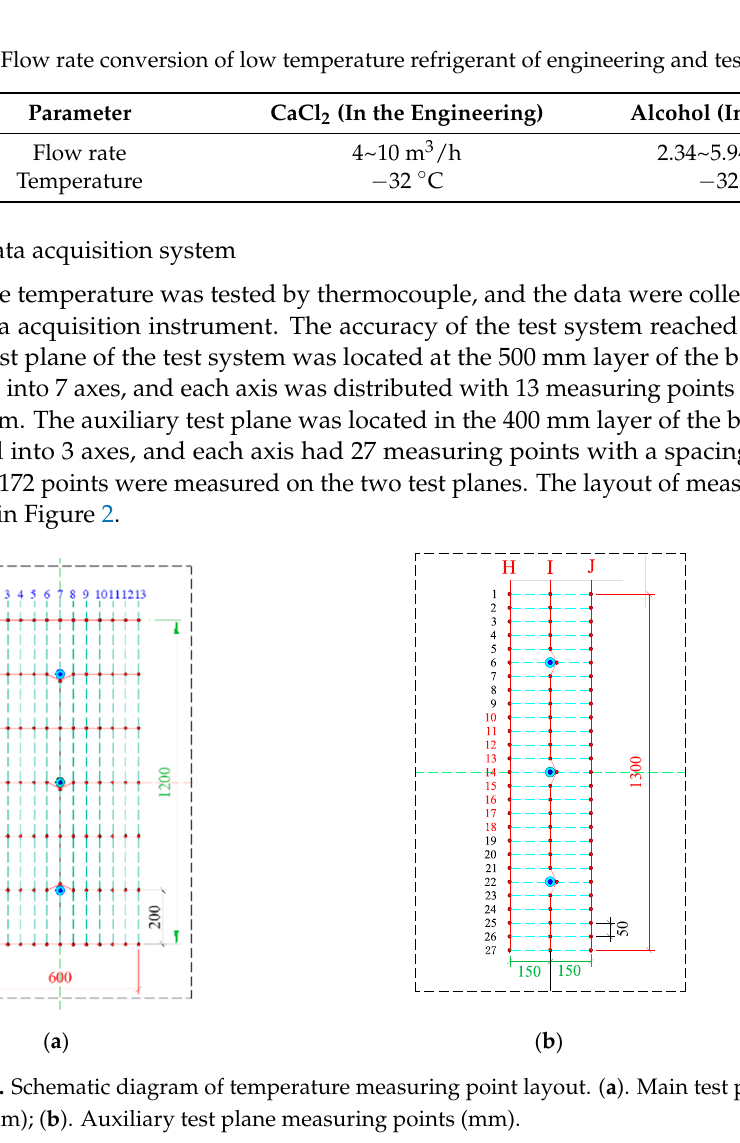
Table 3. Comparison of physical parameters between CaCl 2 and alcohol.